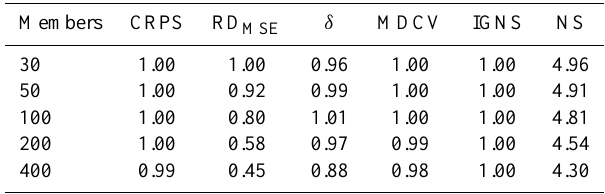
Table 4. Median of 200 random selections in catchment H36 for the lead time 9. The scores are presented in a standardized fashion and oriented at the minimization coinciding with the formulation of each component of the combined criterion (Eq. 7).